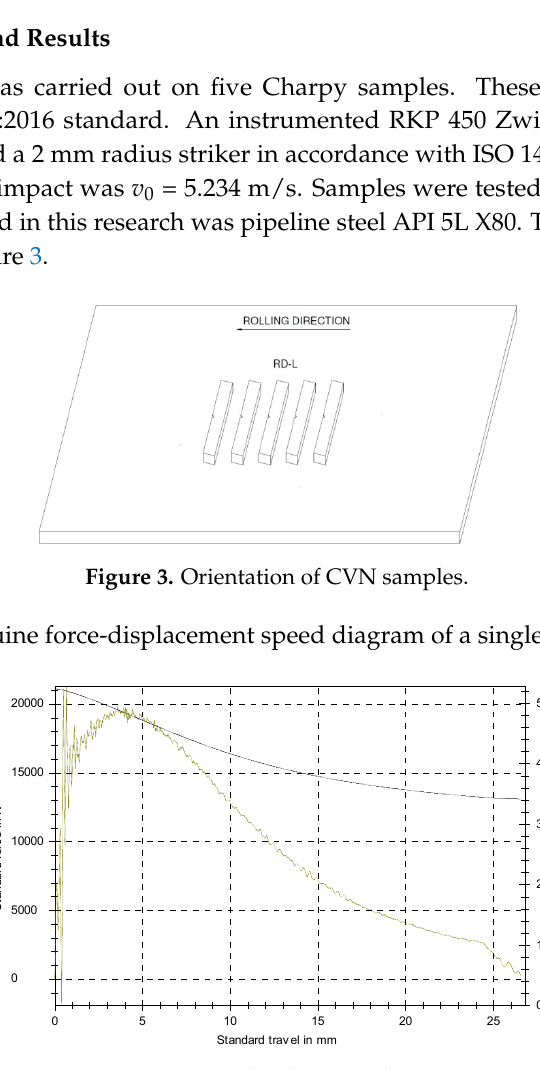
Table 1. Constraint factor values at maximum force.